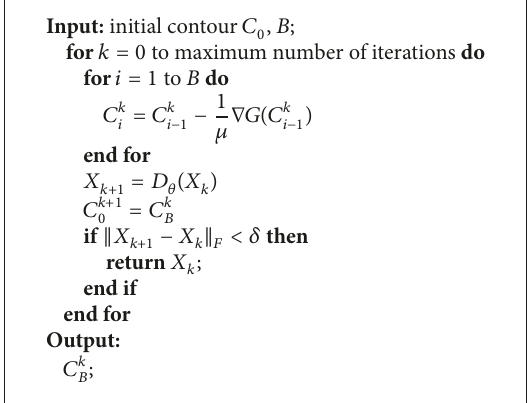
Algorithm 1: Block evolution algorithm.